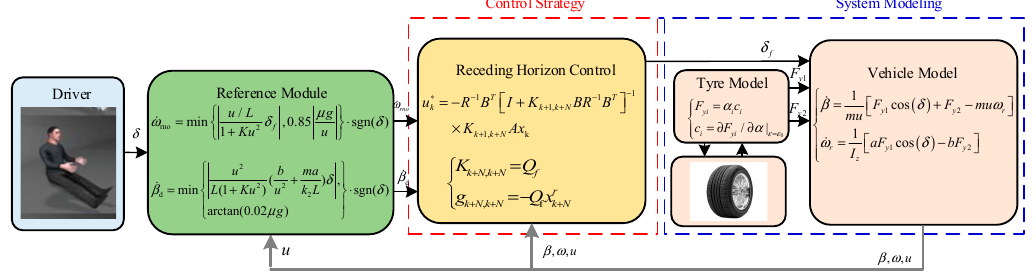
Figure 1. Global control strategy for receding horizon control.